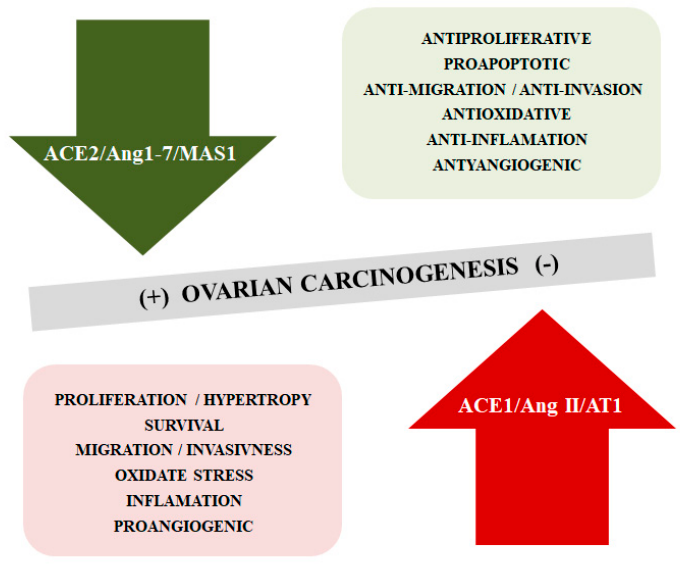
Figure 3. The opposite function of ACE2/Ang-(1–7)/MAS1 and ACE1/AngII/AT1 axis in the ovarian